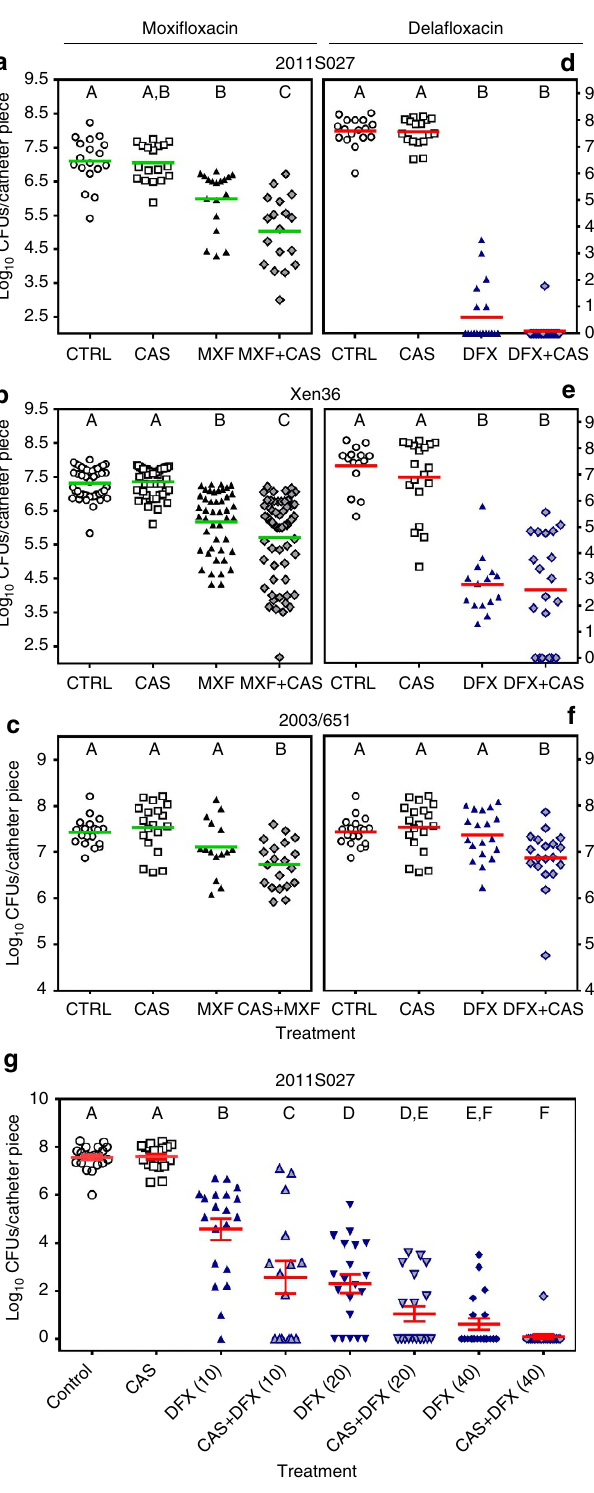
Figure 5 | Activity of fluoroquinolones alone or combined with